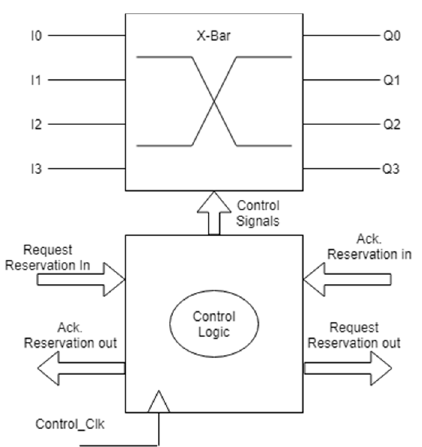
Figure 2. The router architecture under the circuit-switching technique with a synchronous control layer and an asynchronous data transfer layer.